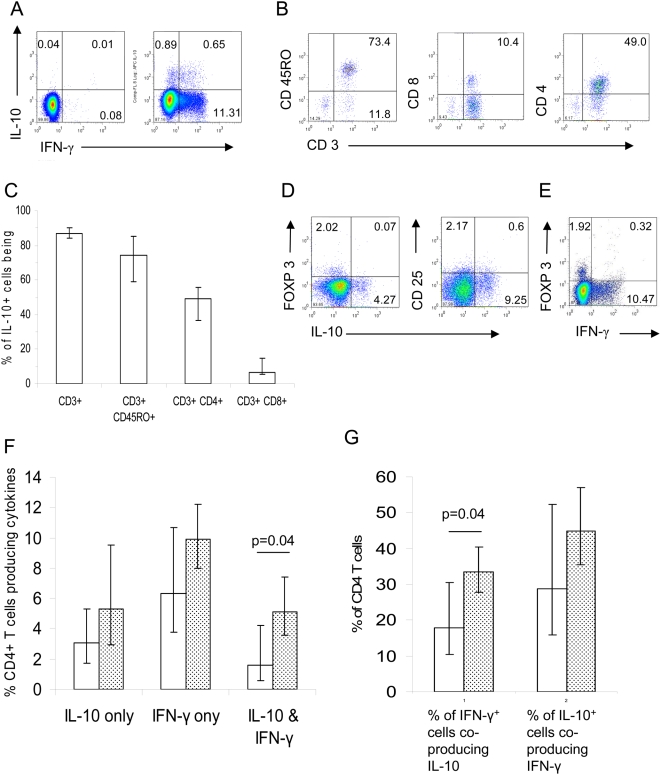
Phenotypic characterization of cytokine-producing cells.PBMC from 30 children with acute P. falciparum infection were cultured with growth medium (GM) or pulsed with PMA and Ionomycin (P/I) for 5 hours and assessed for the production of IL-10 and IFN-γ by flowcytometry. (A) representative example of PBMC stained with isotype control (left panel) or anti- IL-10 and anti-IFN-γ (right panel). (B) Representative example of the phenotype of IL-10 producing cells. (C) Proportion of IL-10 producing cells. The geometric mean with CI95% is shown. (D) Representative example of co-staining for IL-10 and FOXP3 (left panel) or CD25 (right panel). Across all samples tested, 0.13% (median; CI 95%: 0.09–0.16%) of PBMC stained positively for both IL-10 and FOXP3, corresponding to 2.4% (median; CI95%: 1.7–4%) of IL-10 producing cells being FOXP3+. Approx 0.79% (median; CI95%: 0.69–1.1%) of CD3+CD4+ PBMC were IL-10+ and CD25+, corresponding to a 8.68% (median; CI 95%: 4.9–9.8%) of IL-10+T cells being CD25+. (E) Representative example of co-staining for IFN-γ and FOXP3. Across all samples tested, 0.29% (median; CI 95%: 0.21–0.37%) of PBMC stained positively for both IFN-γ and FOXP3, corresponding to 0.97% (median; CI95%: 0.67–1.27%) of IFN-γ producing cells being FOXP3+. (F) Percentage of IL-10 single positive, IFN-γ single positive, and IL-10/IFN-γ double positive CD4+ T cells from 17 children with severe (open bars) and 13 children with uncomplicated (shaded bars) malaria are shown. PBMC were activated with P/I for 5 hours prior to staining. (G) The percentage of IFN-γ producing CD4+ T cells co-producing IL-10, as well as the percentage of IL-10 producing CD4+ T cells co-producing IFN-γ is shown for severe (open bars) and uncomplicated (shaded bars) cases. Bars in (F) and (G) represent the geometric mean with 95% CI.